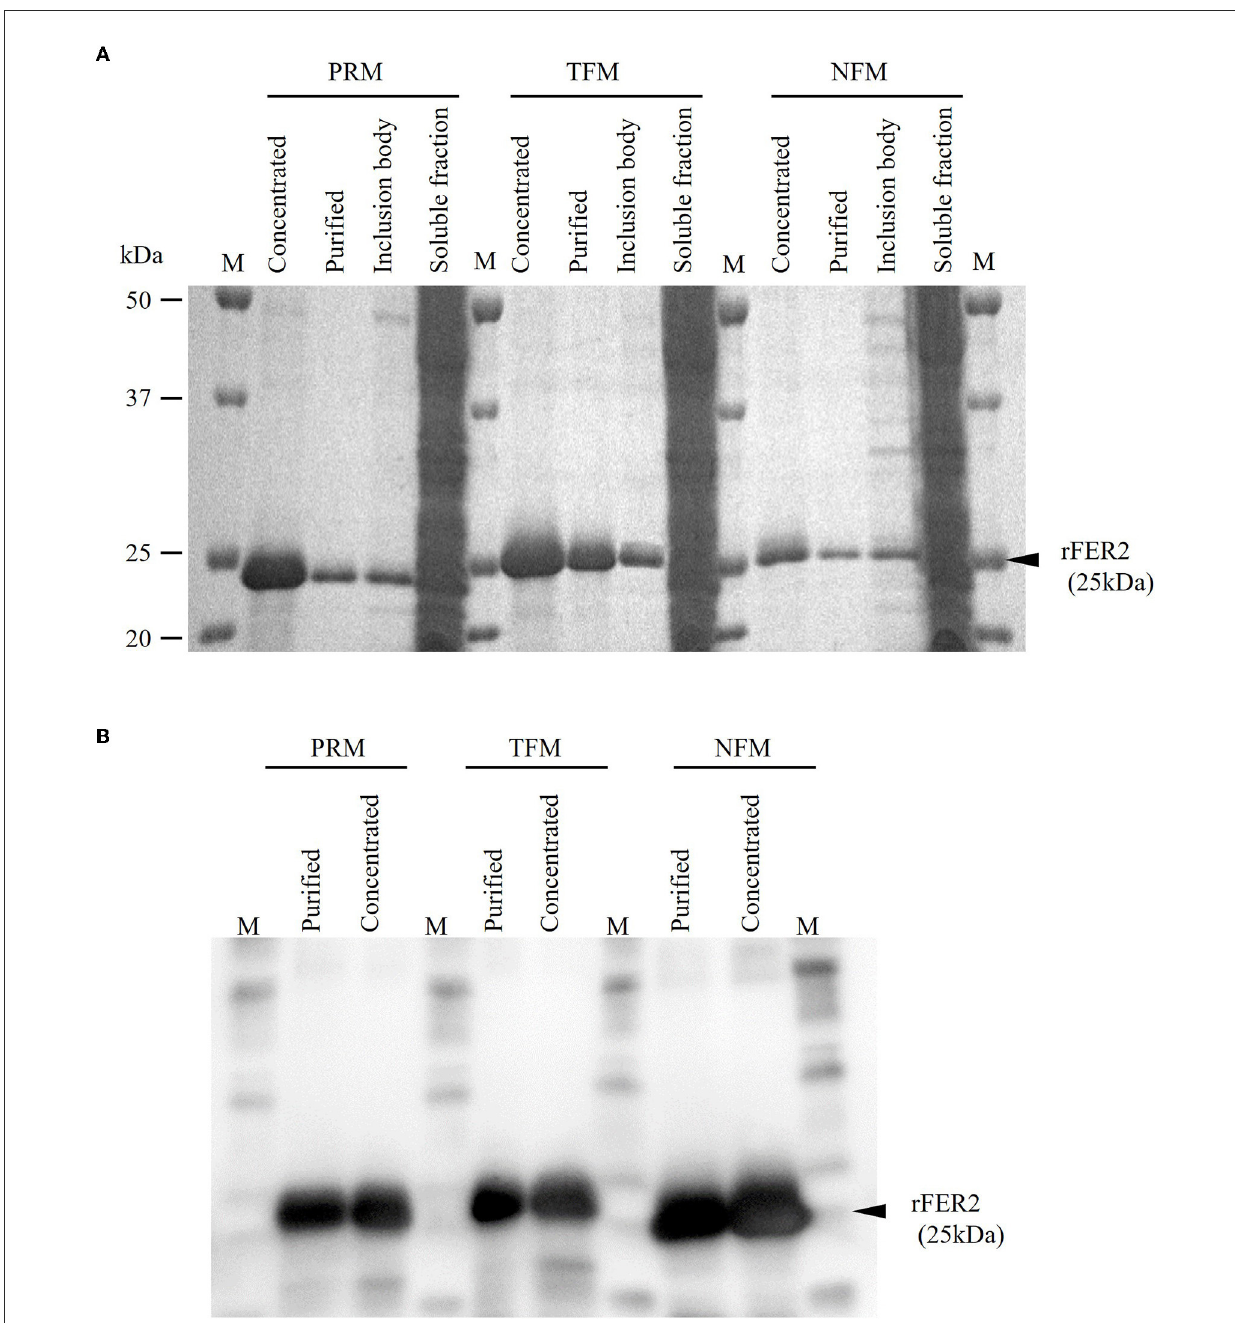
FIGURE2 Expression and purification of recombinant ferritin 2 (rFER2) proteins. The ferritin 2 from poultry red mites (PRMs), tropical fowl mite (TFMs), and northern fowl mites (NFMs) were expressed and purified as recombinant proteins fused with histidine tag, and named as rFER2 PRM, rFER2 TFM, and rFER2 NFM, respectively. rFER2 from each mite was expressed in Escherichia coli and purified from the inclusion body fraction by affinity chromatography. The purity of rFER2 was confirmed by sodium dodecyl sulfate-polyacrylamide gel electrophoresis (A) and Western blotting (B) . M, Marker (Precision Plus Protein TM All Blue Prestained Protein Standards; Bio-Rad, Hercules, CA, USA).